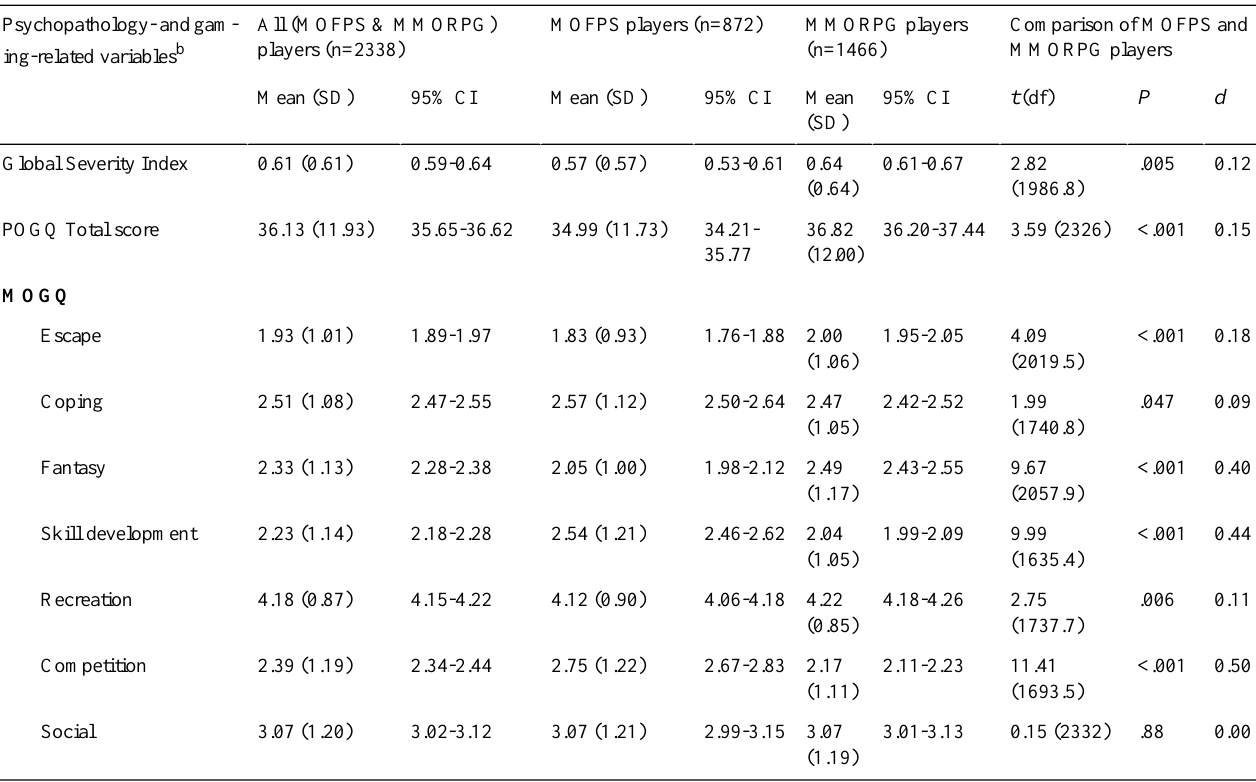
Table 2. Means, standard deviations (SD), and confidence intervals (CI) for multiplayer online first-person shooter (MOFPS) and massively multiplayer online role-playing games (MMORPGs) gamer types examined and for all players (MOFPS and MMORPG) a and effect sizes (Cohen’s d